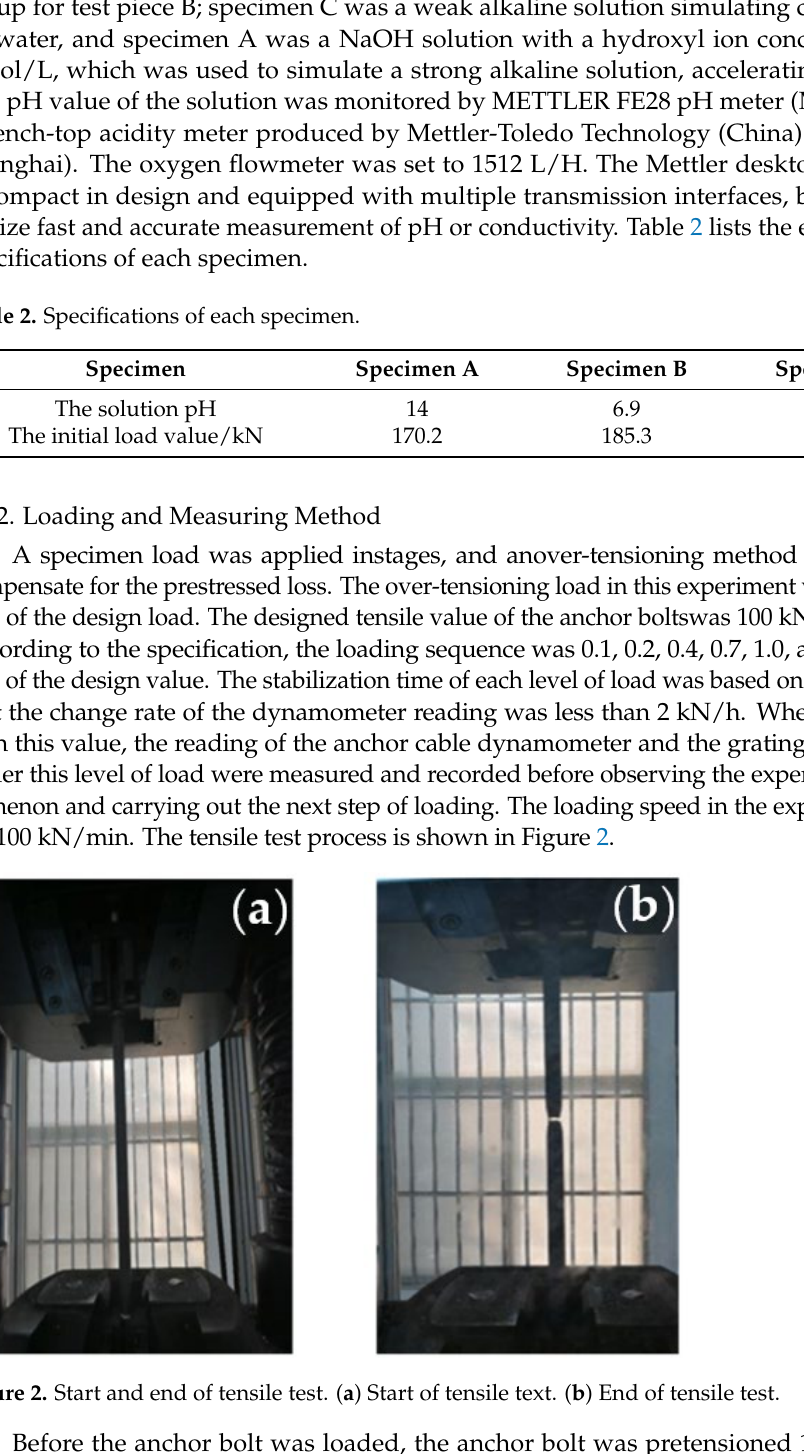
Table 2. Specifications of each specimen.